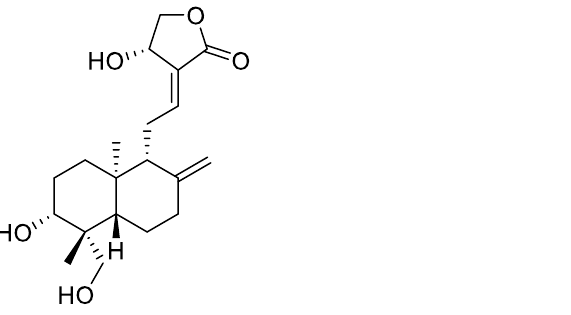
Figure 16. The chemical structure of the andrographolide compound.